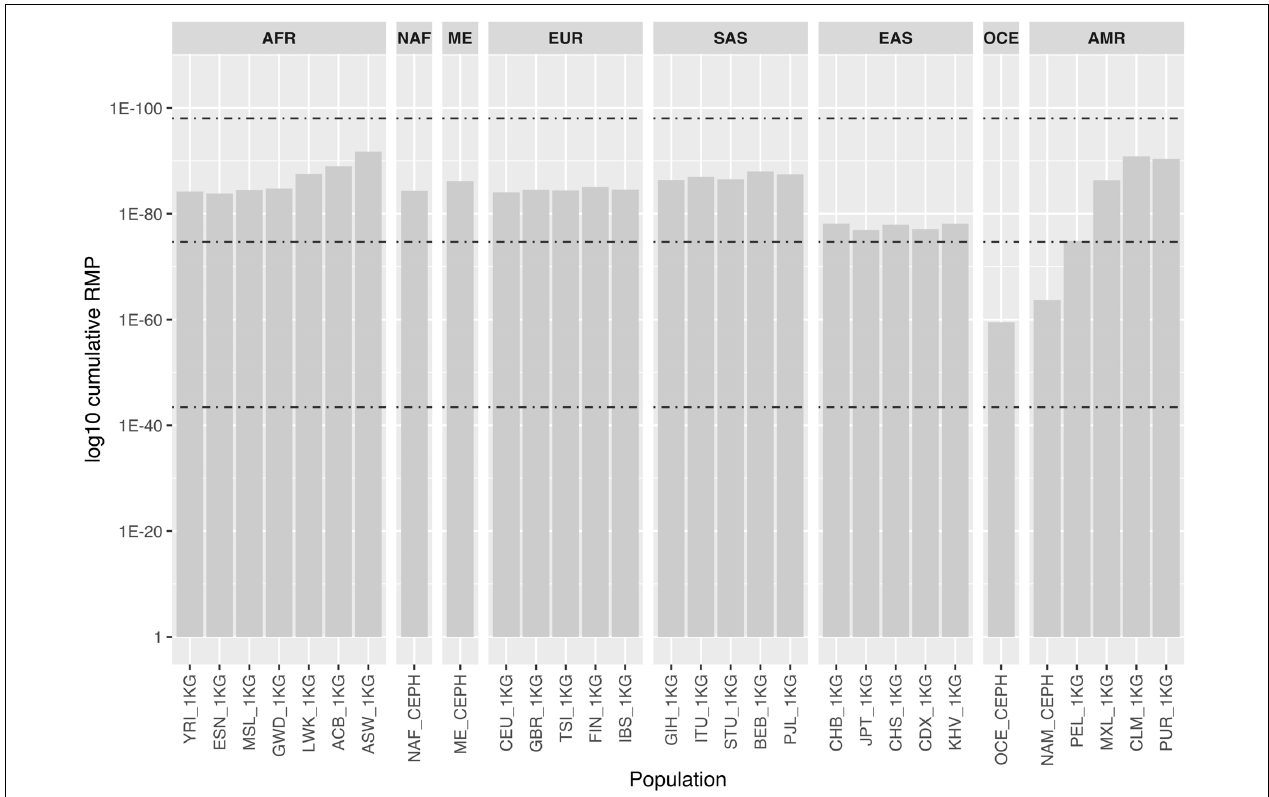
FIGURE 2 | Bar chart represents log10 cumulative random match probability values (i.e., the probability that two individuals share the same profile) for the 30 populations considered, based on the autosomal MH data only. Populations are named and grouped into eight major populations according to Supplementary Table S5 . Dashed lines represent, from bottom to top, the theoretical values for a panel composed of 102 perfectly balanced bi, tri and tetra-allelic SNPs for comparison: 3.56E-44, 1.98E-75, and 9.32E-99,